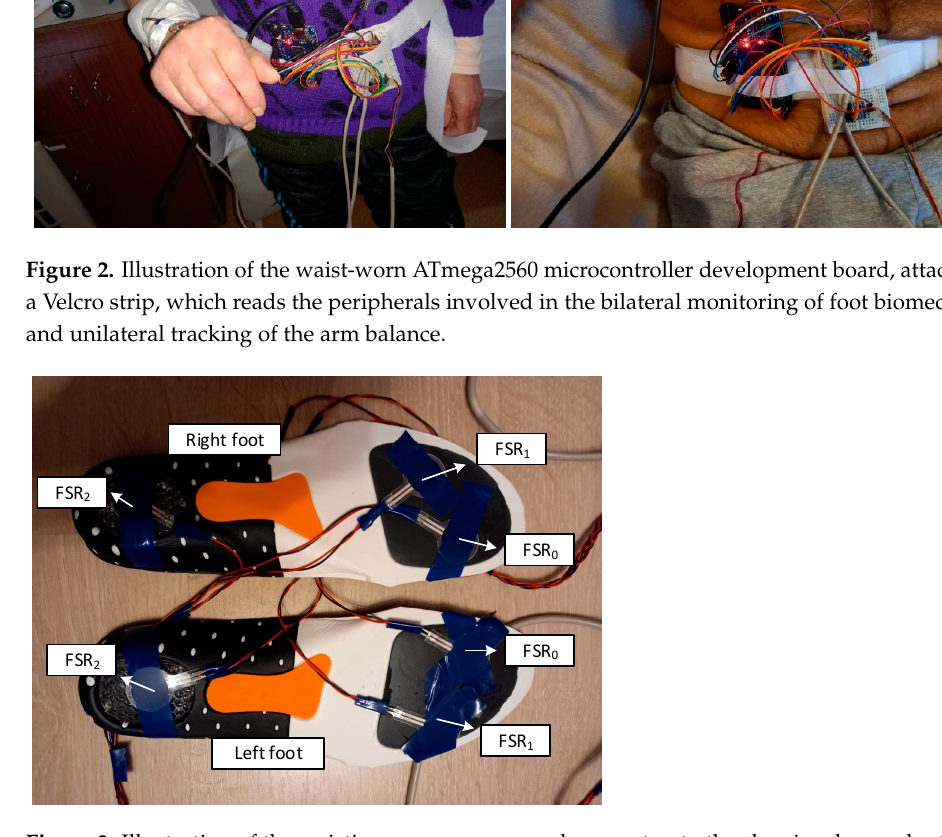
Figure 3. Illustration of the resistive pressure sensor placement onto the shoe insoles, under the toe, metatarsal arch, and heel area, respectively, for bilateral tracking of the plantar pressure progression pattern along the center of pressure progression line.